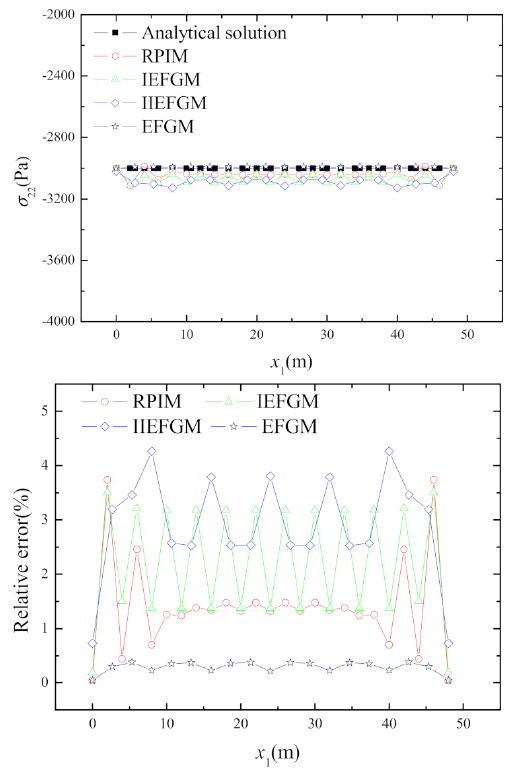
Figure 3. Stress σ 22 and its relative error at x 2 = 0 m